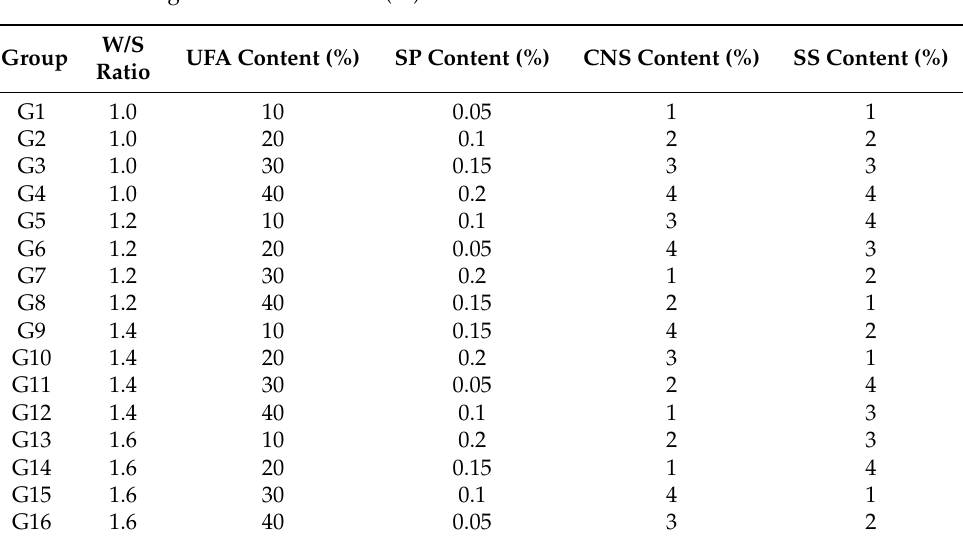
Table 4. The orthogonal test scheme L16(4 5